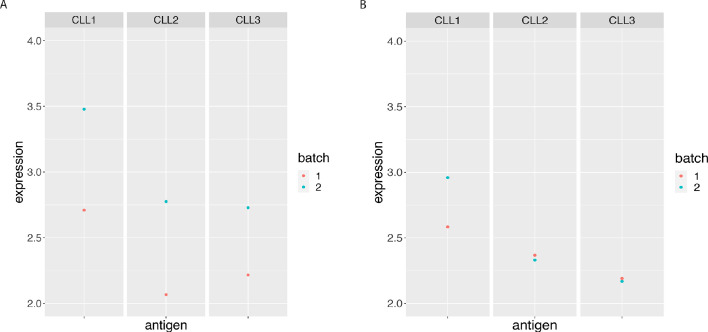
BCL-2 median expression in the main CLL cluster from the 3 CLL samples replicated across 2 CyTOF runs.(A) Before and (B) After CytofRUV normalisation with k = 5.